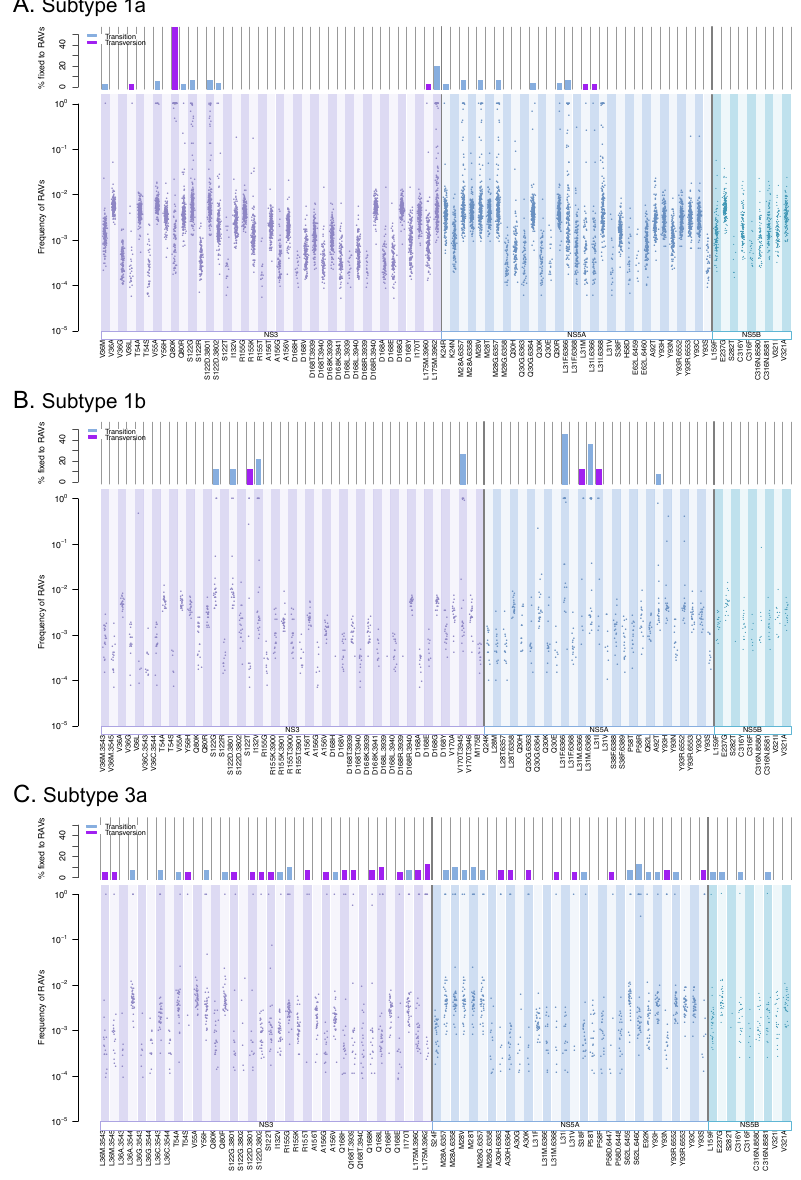
Figure 7. Natural occurrence of resistance-associated variants (RAVs) in HCV subtypes (( A ): subtype 1a, ( B ): subtype 1b, ( C ): subtype 3a). The upper plot in each figure shows the proportion (%) of samples with RAVs as a majority nucleotide within each subtype. The bottom figure shows the observed frequency of RAVs. Each dot represents a RAV frequency at a specified location in each sample